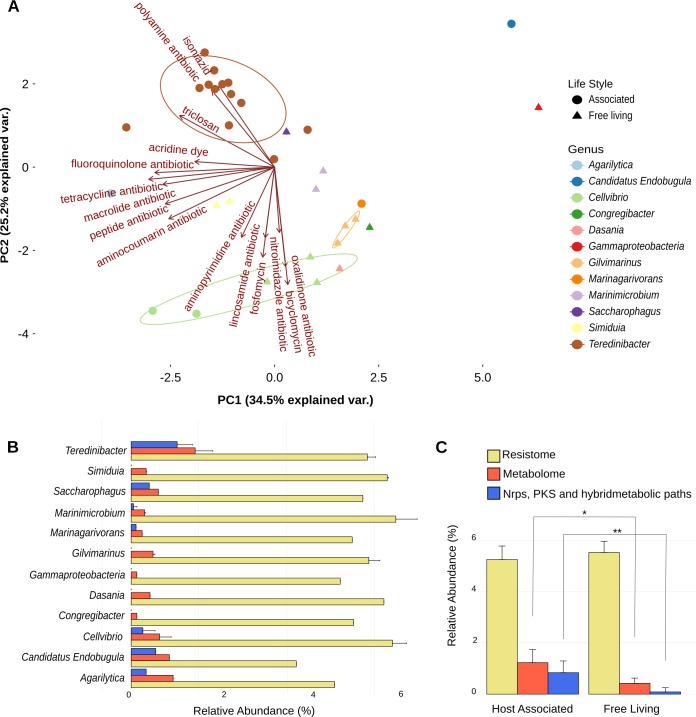
Teredinibacter resistome.A) resistome PCA using the fifteen most important genes based on mean decrease accuracy of Random Forest analysis. Teredinibacter forms a major group influenced by polyamine, isoniazid, and PK-NRP-derived antibiotics. B) Relative abundance of resistance gene markers, BGCs, and NRPS, PKS and hybrid BGCs. C) Host associated bacteria present a significantly larger metabolome and abundance of NRPS, PKS and their hybrid metabolic paths than free living bacteria. One asterisk represents Kruskal-Wallis test p-values <0.001 and two represent <0.0001 both adjusted with Bonferroni method.